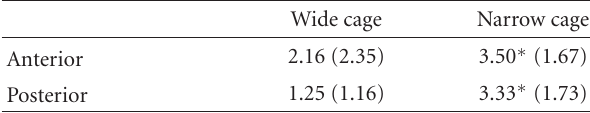
Table 2: Subsidence: mean (mm) and standard